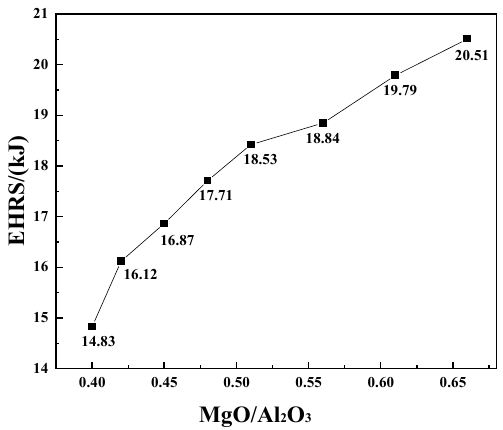
Figure 8. Effect of MgO/Al 2 O 3 on the value of EHRS.